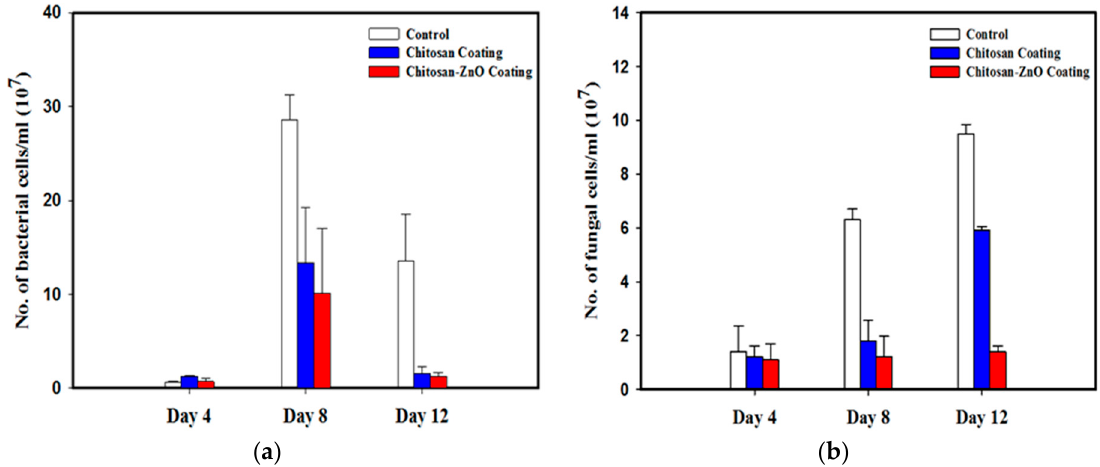
Figure 4. Number of ( a ) bacterial and ( b ) fungal cells (CFU/ml) in okra samples packed in coated and uncoated LDPE films, and incubated for 4, 8 and 12 days.